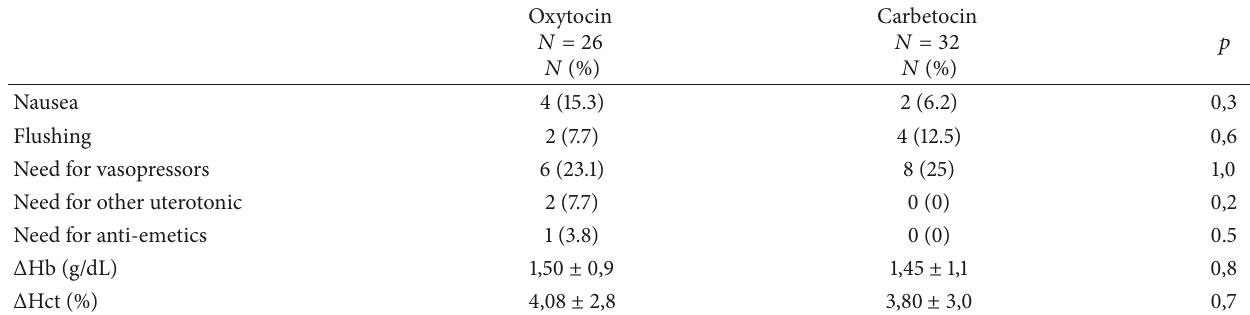
Table 2: Adverse